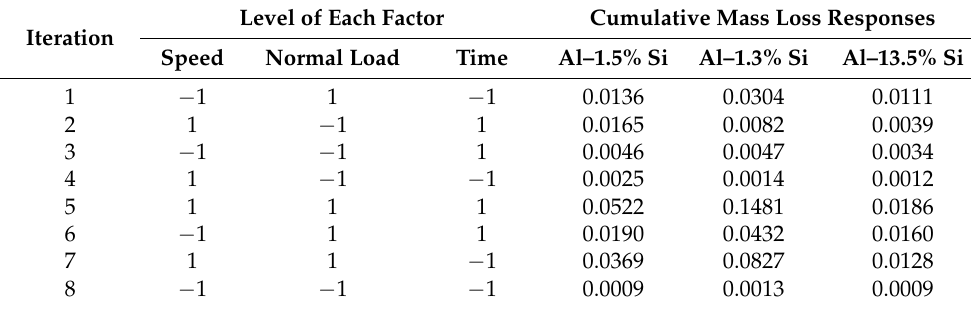
Figure 10. ( a – c ) Surface roughness profiles for Al–1.3%Si, Al–1.5%Si, and Al–13.5%Si alloys, respec- tively, in three directions, i.e., 0 ◦ , 45 ◦ , and 90 ◦ to the streak direction. ( d ) Roughness indices at 0 ◦ , 45 ◦ , and 90 ◦ versus Si concentration for the three Al–Si compositions. Table 5. List of test conditions for each alloy